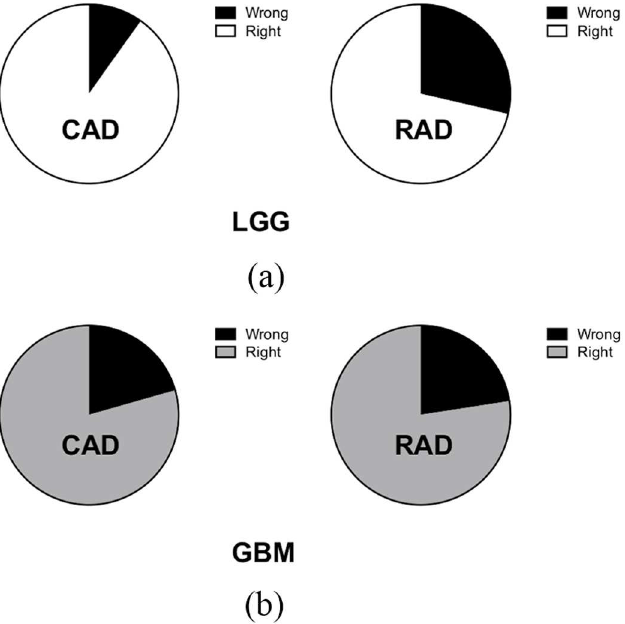
Fig 5. Misdiagnosis percentages of the computer-aided diagnosis (CAD) systemand radiologists in both the low-grade glioma (LGG) and glioblastoma (GBM) groups. (a) Remarkably highermisdiagnosis rates of radiologiststhan that of the CAD system were noted in the LGG group. (b) Similar misdiagnosis rates of both radiologistsand CAD were noted in the GBM group. (RAD: radiologist-based